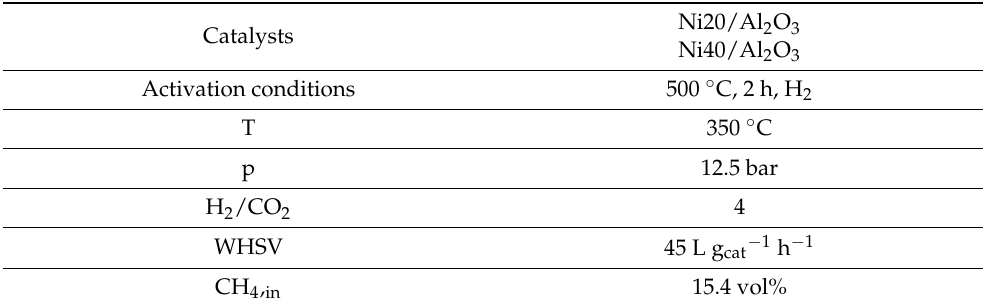
Table 8. Catalyst and reaction conditions for microchannel reactor experiments on CH 4 influence on methanation with unpromoted Ni/Al 2 O 3 [99].